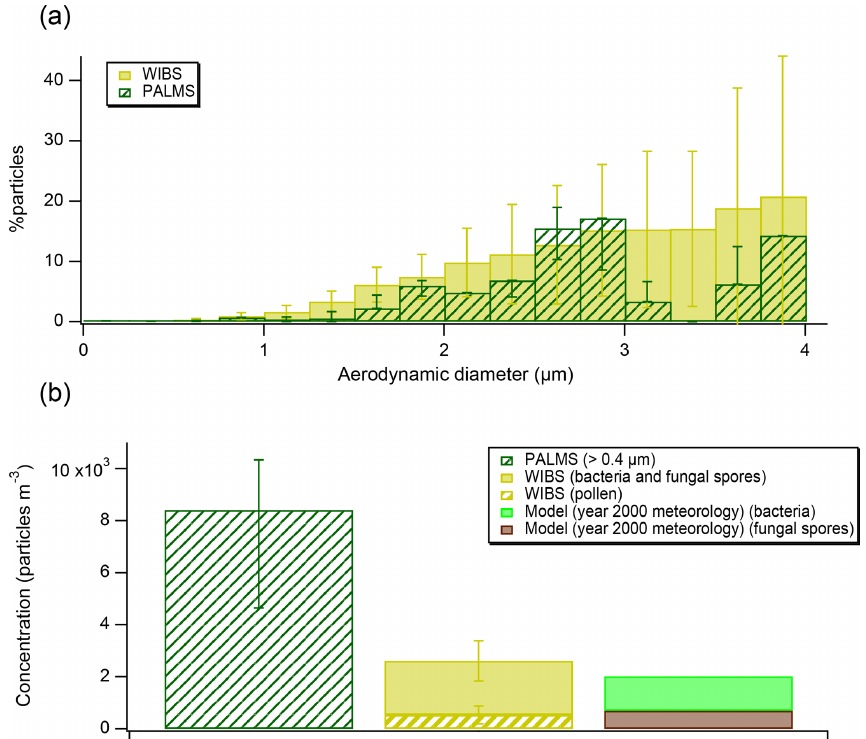
Figure 3. (a) Bioaerosol abundances (as percent of all particles) detected by PALMS and WIBS, grouped into size bins. The error bars on PALMS data correspond to particle type assignment confidence estimated using laboratory data and SVMs algorithm. The error bars on WIBS data represent standard deviations of the hourly average in each size bin. (b) A comparison of measured concentrations from FIN03 and aerosol model results (note, model was initialized using year 2000 meteorology). A lower cut-off size of 0.4µm has been used to report PALMS concentrations to match the WIBS size